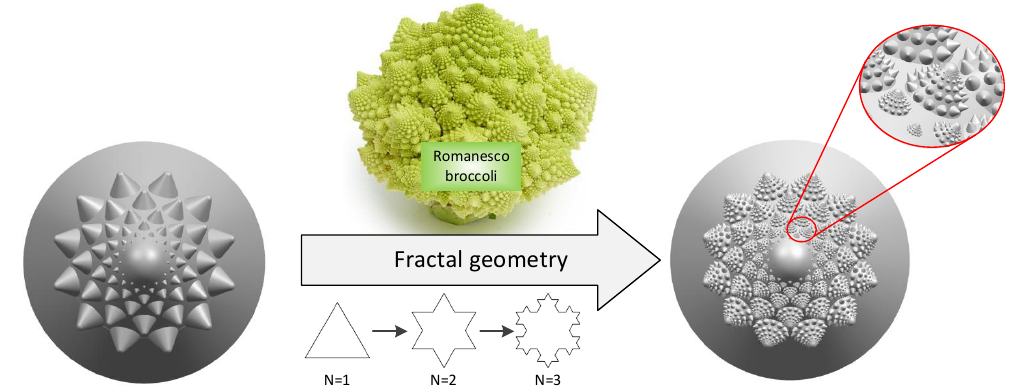
Figure 4. Biomimetic mapping of romanesco broccoli using fractal